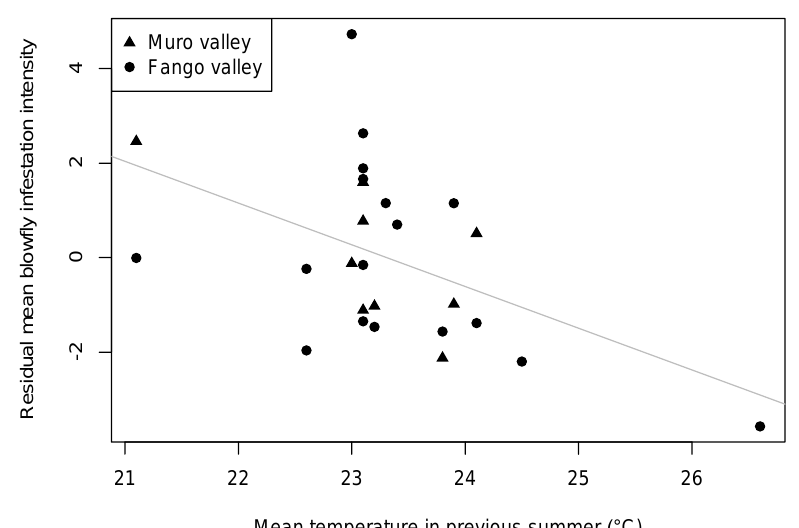
Figure 3. Across years, parasite load (corrected for ambient temperature during nesting) decreases with increasing mean temperatures in the previous summer (i.e. during the adult, free-living stage of Protocalliphora blow flies). Dots represent yearly mean values.